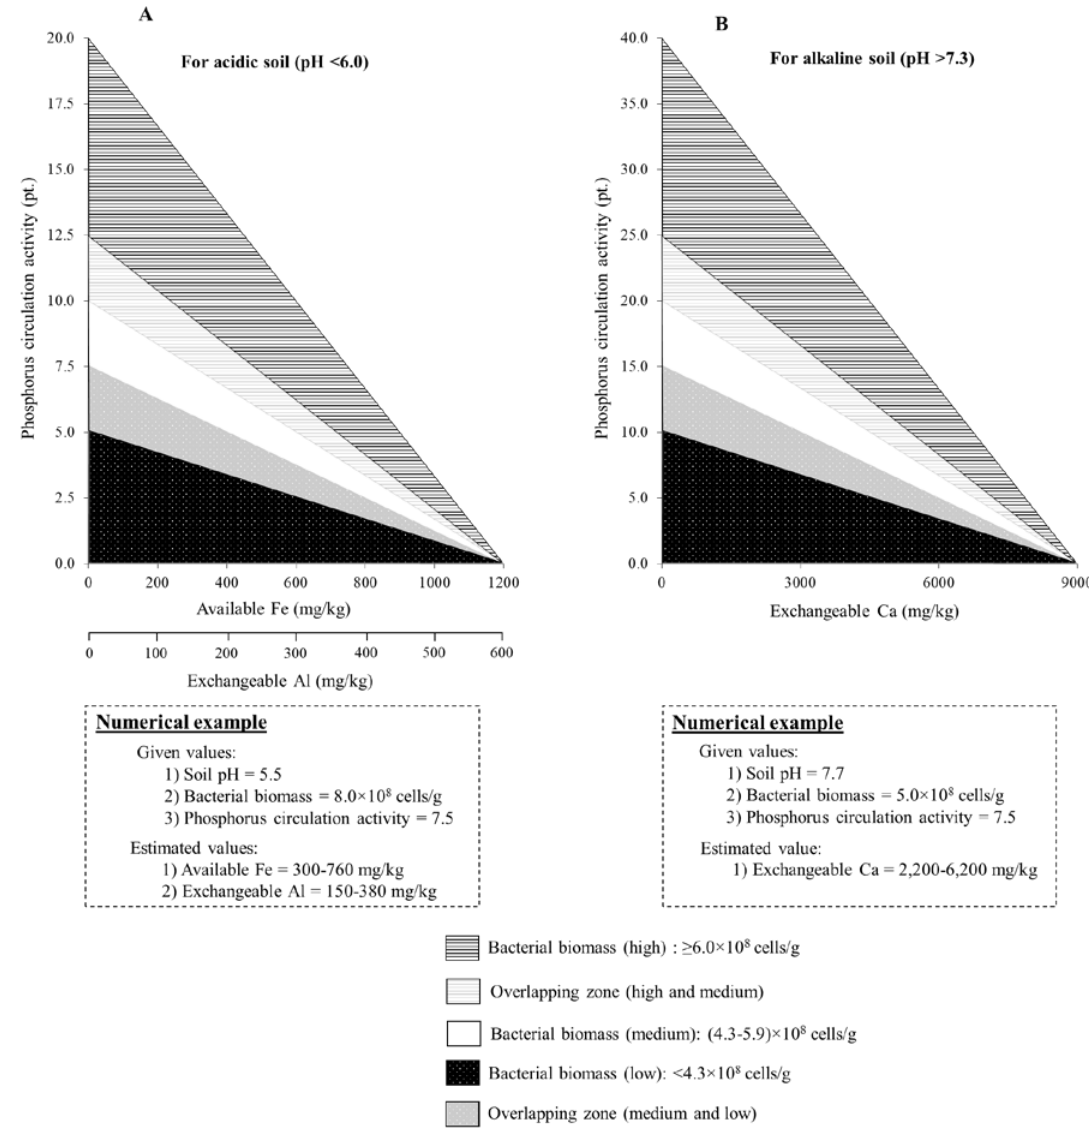
Figure 5. Model showing the relationship among phosphorus circulation activity, bacterial biomass, pH, and mineral concentration. ( A ) Available Fe or exchangeable Al at acidic pH range (<6.0) and ( B ) exchangeable Ca at alkaline pH range (>7.3). Examples of estimating concentrations of Fe, Al, and Ca using the model are also shown.